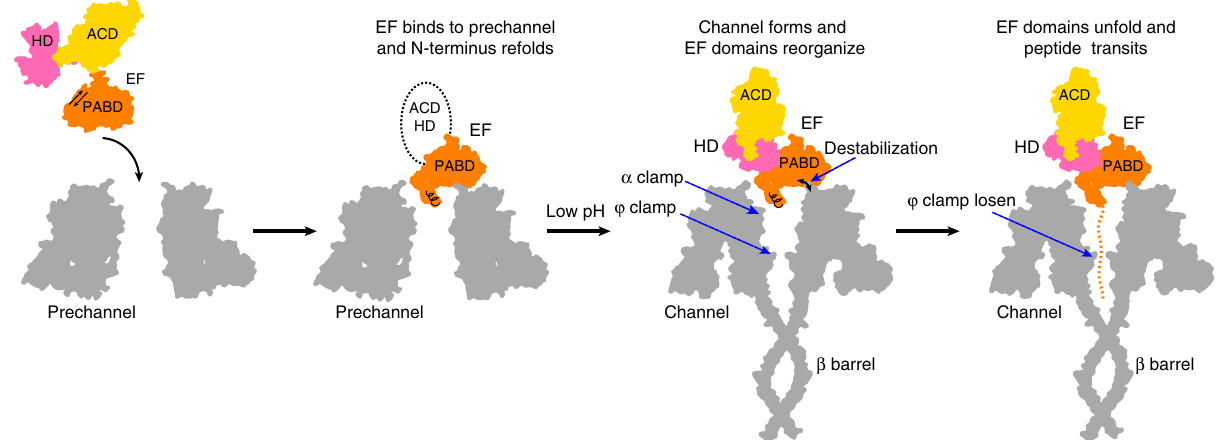
Fig. 4 Mechanism of EF translocation. Illustration of the anthrax toxin channel translocation steps with EF. Initially, EF binds to the PA pre-channel, and the N-terminal α helix of the PABD of EF docks into the α clamp, yielding the space for domain reorganization of EF. After the PA pre-channel changes to the channel state at low pH, the destabilization of the interface between the PABD of EF and the PA channel allows the N-terminal α helix to translocate down to the ϕ -clamp site. In parallel, the α clamp engages the EF polypeptide again, causing an allosteric change in the ϕ clamp. The change in the ϕ clamp applies force to the α helix, changing its conformation to extended chain and driving it past the charge clamp site located near the top of the β barrel. The cycle repeats on the next section of EF